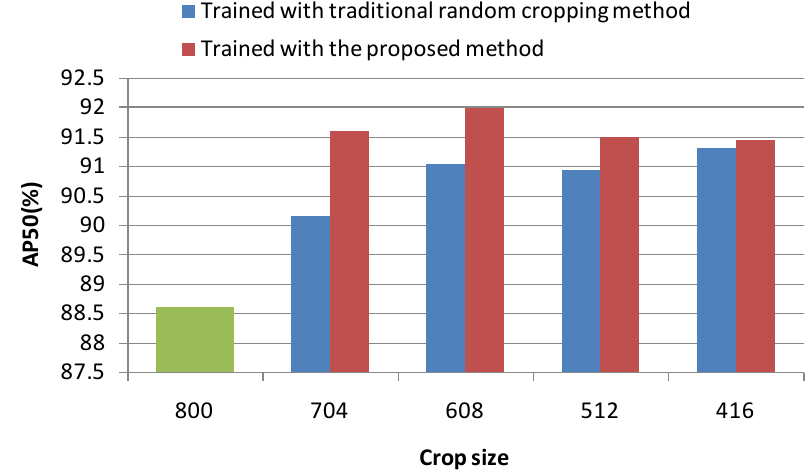
Figure 10. AP50 of different models under different random crop sizes.